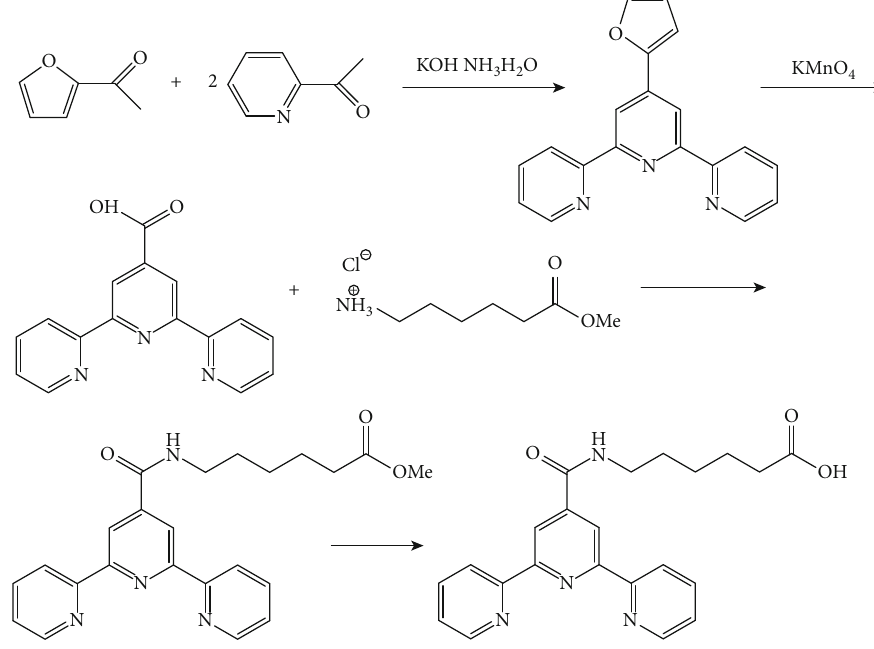
Figure 1: Synthesis route of 6-(2,2 ′ :6 ′ :2 ″ -terpyridine-4 ′ -formamide) hexanoic acid. Table 1: Elemental composition of 4 ′ -(2-furyl)-2,2 ′ :6 ′ ,2 ″ Table 3: Elemental composition of 6-(2,2 ′ :6 ′ ,2 ″ -terpyridine-4 ′ -terpyridine. -formamide) hexanoic acid methyl ester.